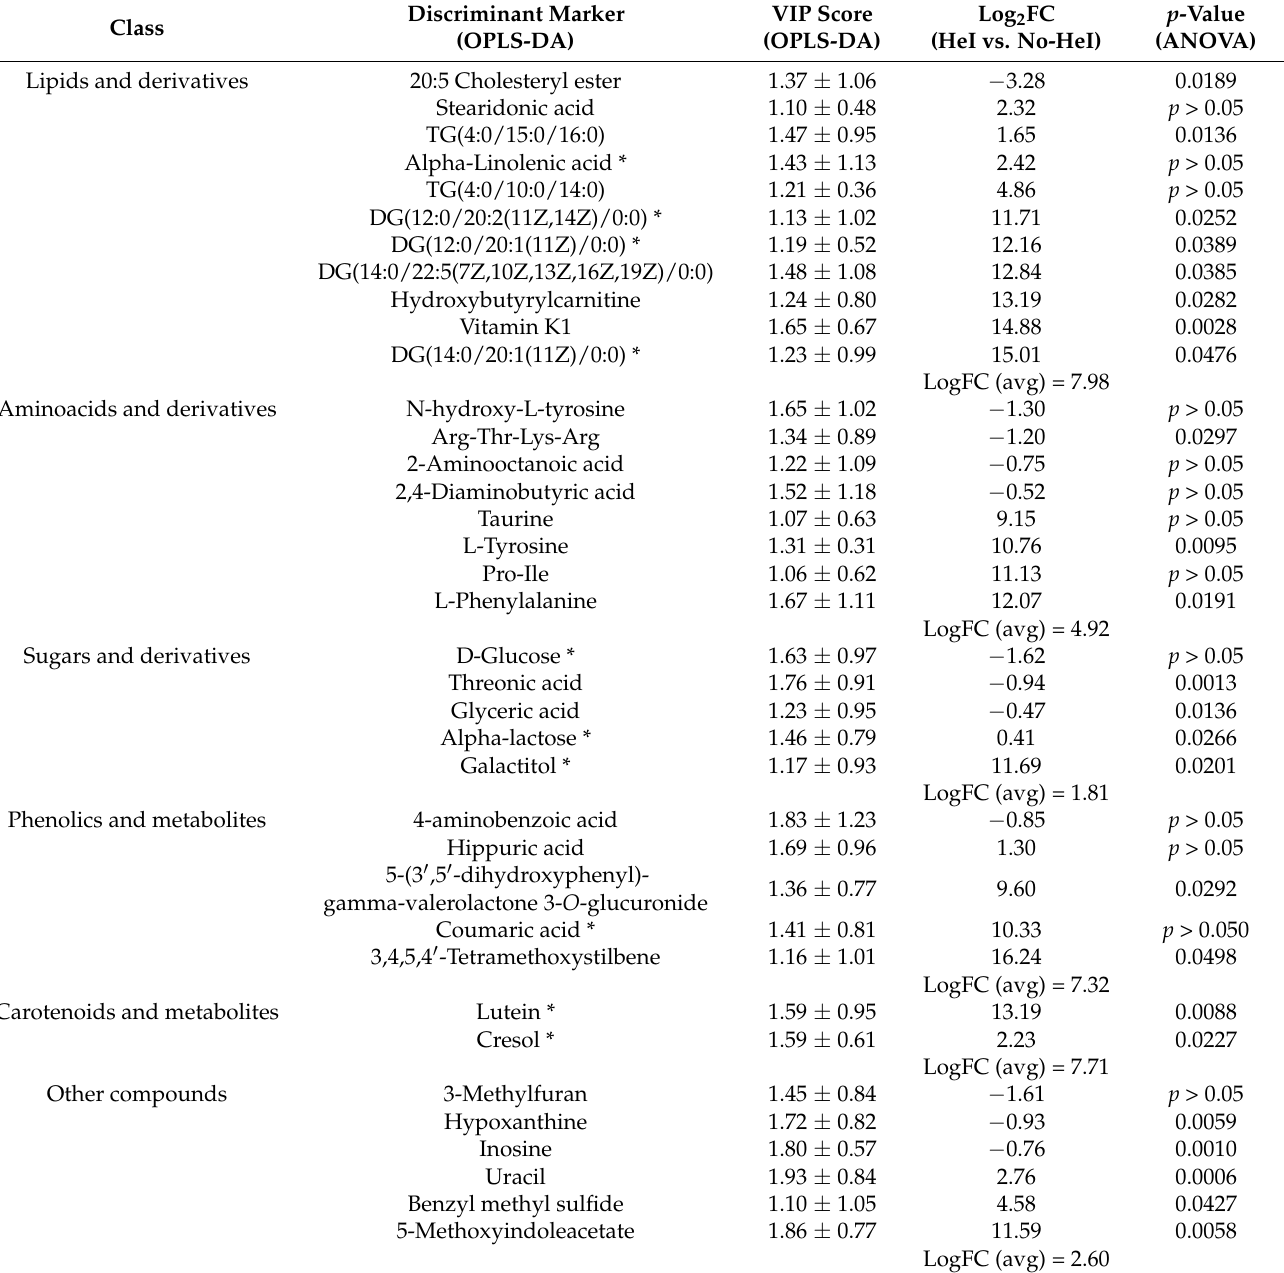
Table 3. VIP discriminant compounds (both down- and up-accumulated) in milk samples as a function of the fresh herbage intake (HeI vs. no-HeI). * = at least 2 isomeric structures (i.e., metabolite species). FC = fold